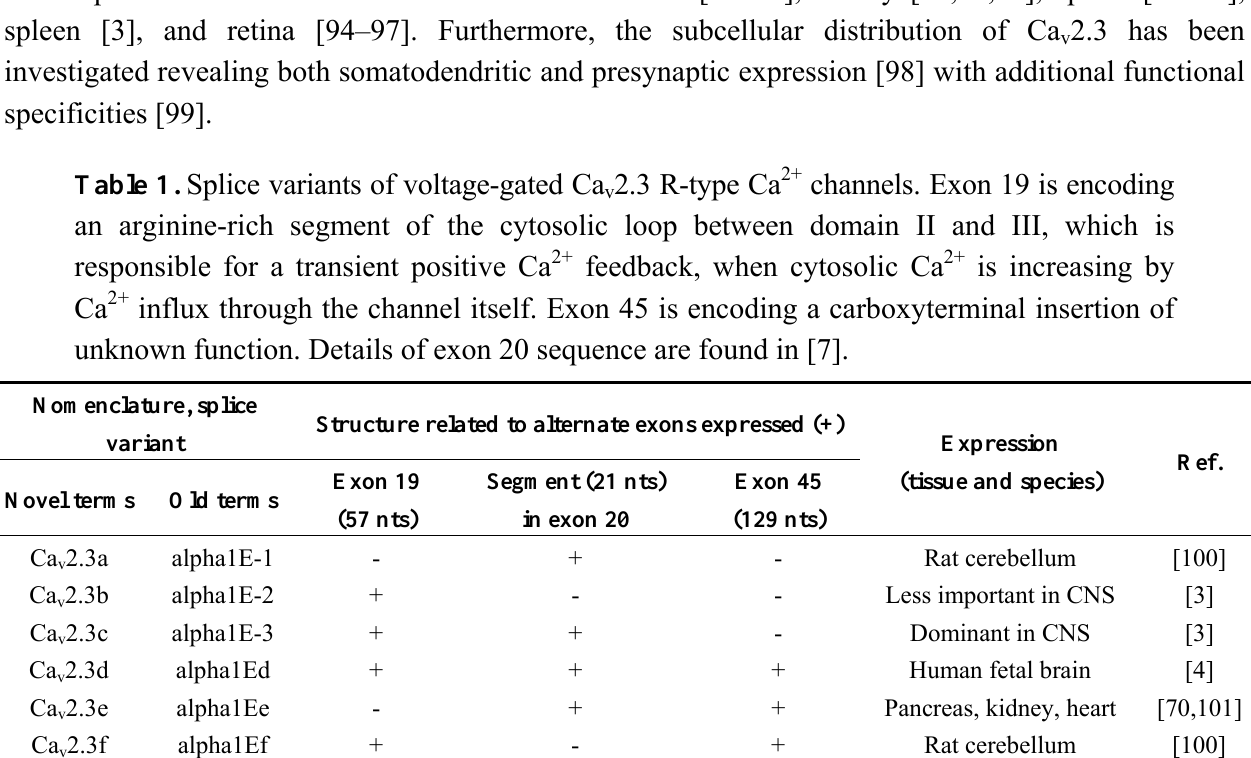
Table 1. Splice variants of voltage-gated Ca